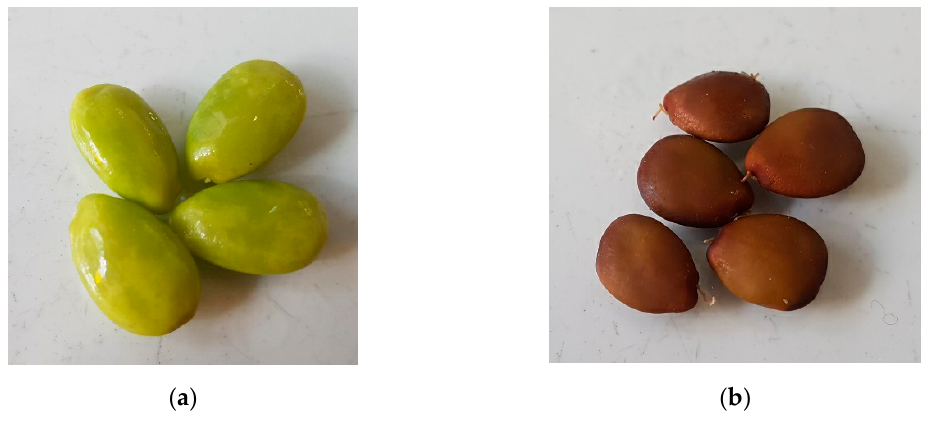
Figure 6. Color changes of carob seeds development. ( a ) Unripe and ( b ) ripe seeds.